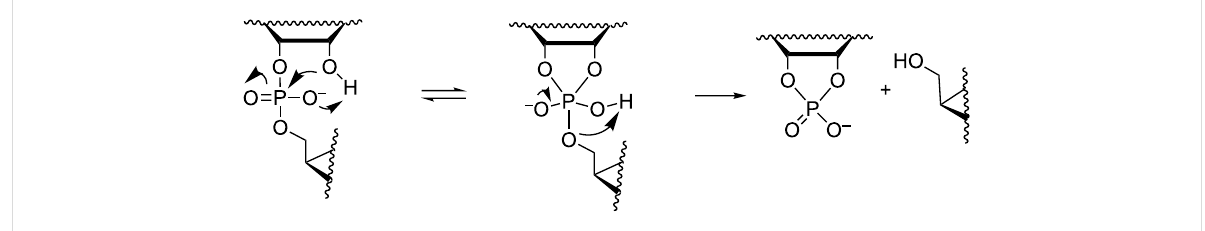
Scheme 2: Mechanism for the pH- and buffer-independent cleavage of RNA phosphodiester